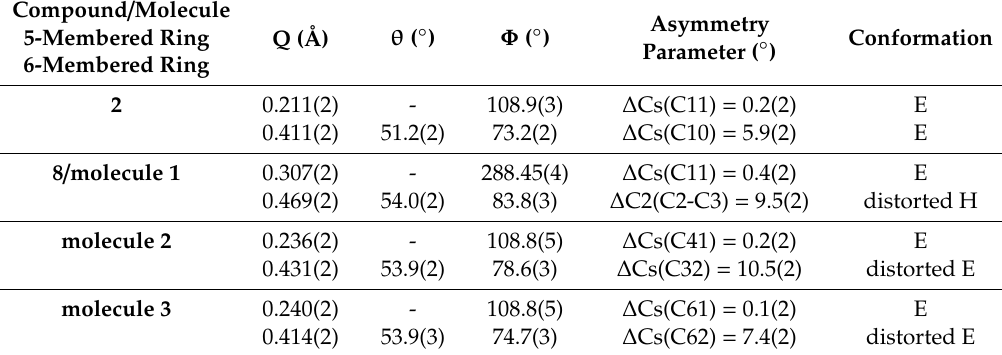
Table 1. Ring puckering parameters with asymmetry parameters and dihedral angle between chromanone skeleton (A / B rings) and C ring.